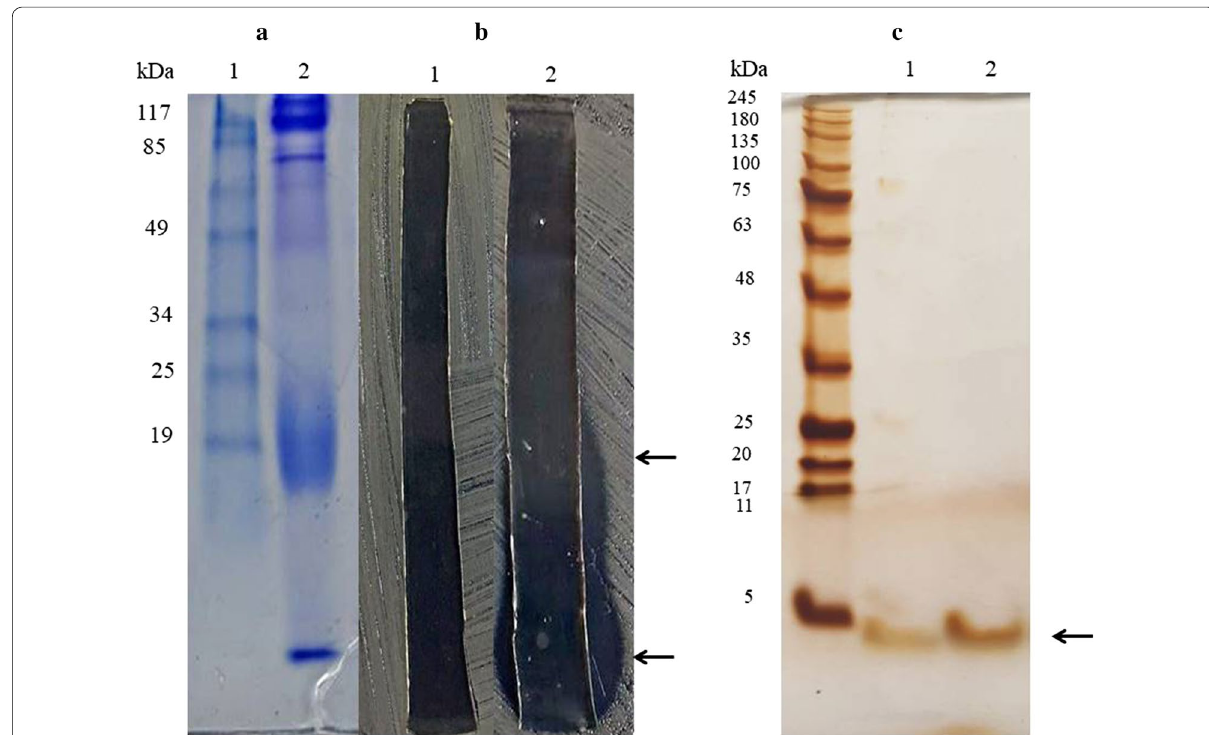
Fig. 4 Gel electrophoresis of crude proteins with antimicrobial activity from KKU1. a Native-PAGE stained with Coomassie Brilliant blue of (1) size marker and (2) the crude proteins from culture supernatant of B. amyloliquefaciens KKU1. b The gel strip of control (1) and precipitated proteins from Native-PAGE (2) that were placed on B. pseudomallei lawns show clear inhibition zones from the action of active compounds. c The SDS-PAGE staining by silver stain of extracted proteins from clear zone positions on Native-PAGE (1) from the lower arrow and (2) from the upper